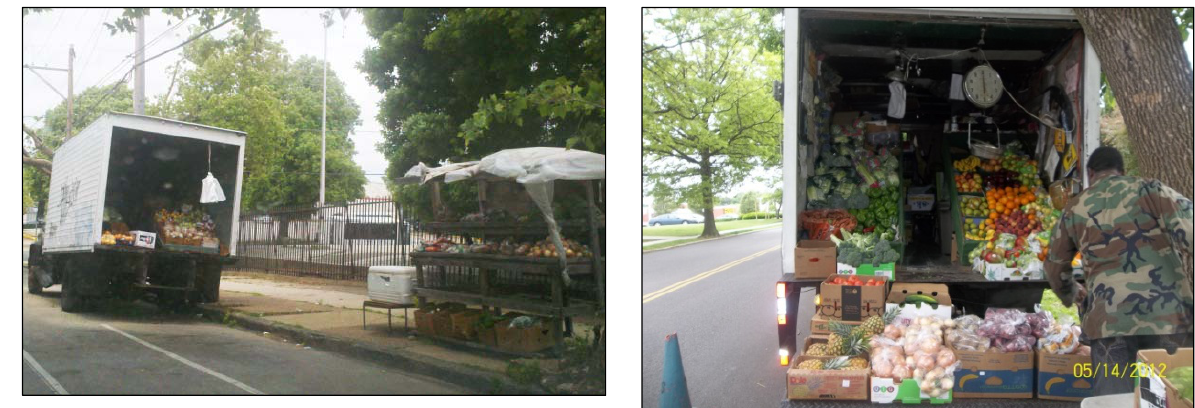
Figure 1. Examples of Two Curbside Produce Vendors